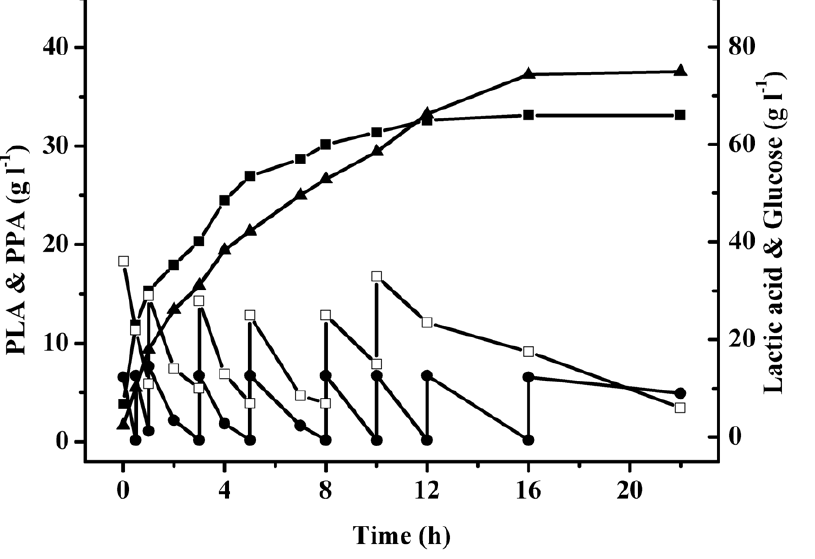
N , PPA; & , lactic acid; % ,